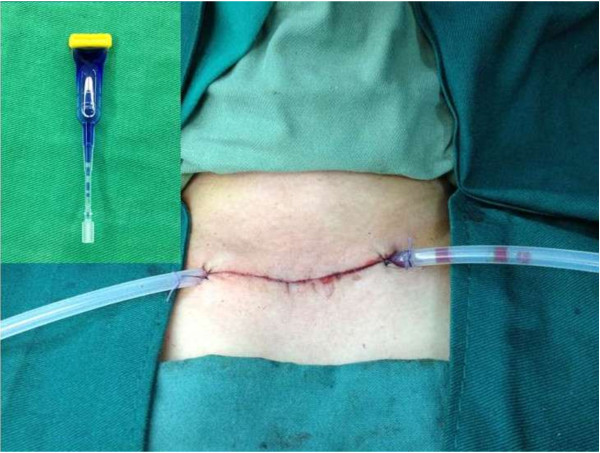
Close incisions of skin with tissue adhesive Histoacryl Blue.